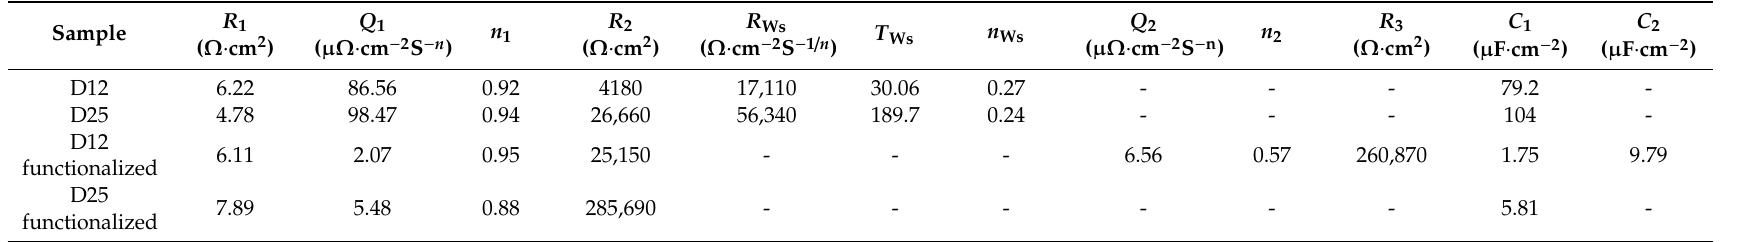
Table 1. Electrochemical parameters obtained from fitting EIS results in Figure 5a,b using equivalent circuit models in Figure